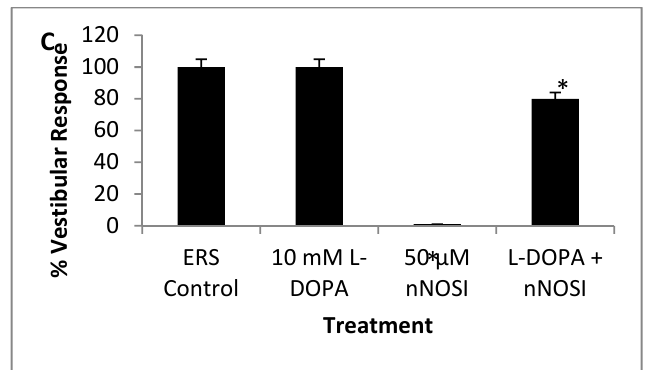
Figure 5. Graphs representing the three components of the listless condition and their appearance in the fish population under various L -DOPA and nNOSI treatment conditions. ( A ) This figure demonstrates the effect of treatment on percentage of zebrafish that respond to probing. After 48 h of treatment, 85% of fish co-treated with both L -DOPA and nNOSI responded to probing compared to 0% of fish treated with only nNOSI (* p < 0.0001). In addition, 100% of fish in both the control and L -DOPA groups responded to probing. Additionally, note that there is no significant difference among the ERS control, L -DOPA, and co-treated groups (* p > 0.05); ( B ) this figure shows the effect of treatment on percentage of zebrafish that swim spontaneously without being probed. One hundred percent of fish from all groups survived. After 48 h of treatment, 45% of fish co-treated with both L -DOPA and nNOSI swam spontaneously without being probed, compared to 0% of fish treated with only nNOSI (* p < 0.001). In addition, 60% of control fish and 50% of L -DOPA treated fish were observed spontaneously swimming. Additionally, note that there is no significant difference among the ERS control, L -DOPA, and co-treated groups (* p > 0.05); ( C ) this figure demonstrates the effect of treatment on percentage of zebrafish that displayed a vestibular (righting) response. After 48 h of treatment, 80% of fish co-treated with L -DOPA and nNOSI were able to maintain their balance, compared to 0% of fish treated with only nNOSI (* p < 0.0001). In addition, 100% of fish in both the control and L -DOPA groups were able to maintain their balance. Additionally, note that there is no significant difference among the ERS control, L -DOPA, and co-treated groups (* p > 0.05). Bars indicate ± SD. In addition, note that 100% of fish from all groups survived.